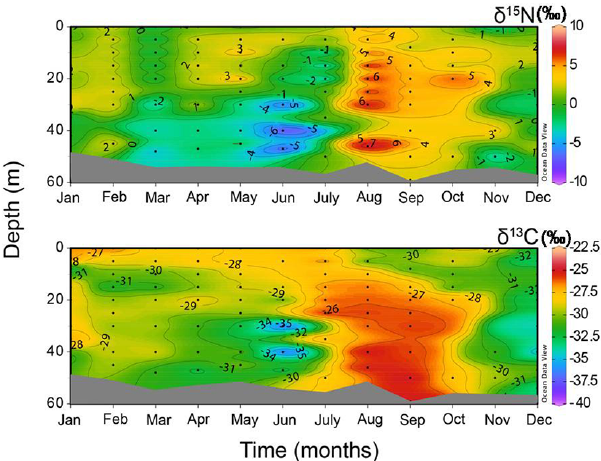
Figure 2. Mean annual variations of δ 15 N POM and δ 13 C POM at the main sampling